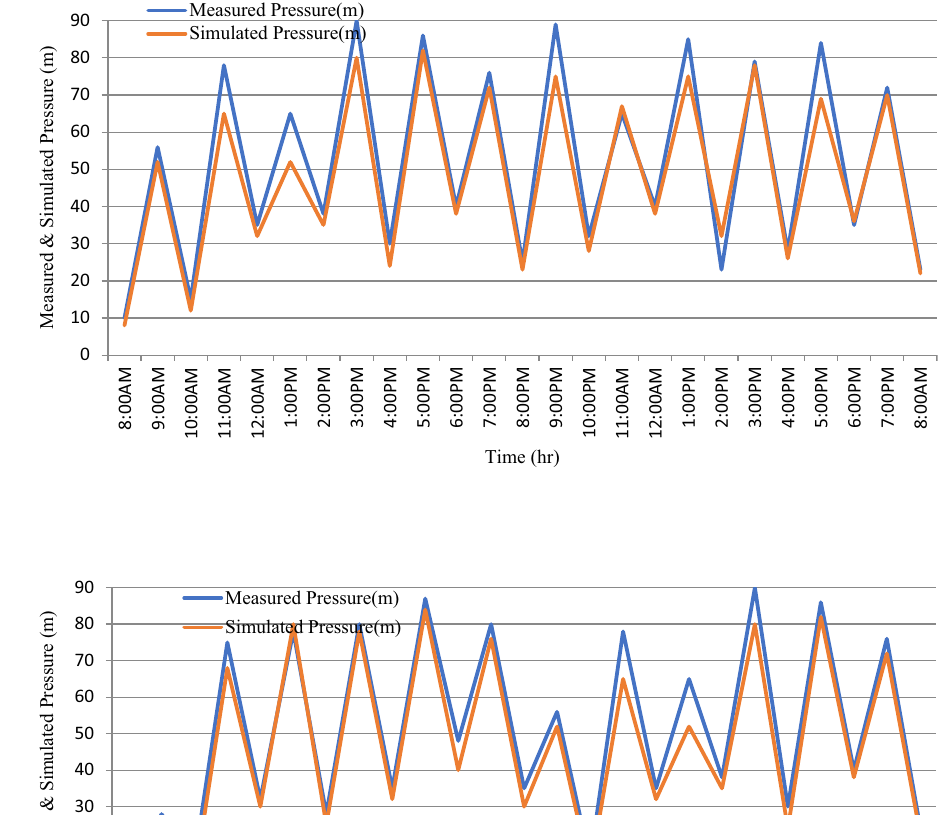
Fig. 4 Calibration model of measured and simulated pres- sures at average daily demand